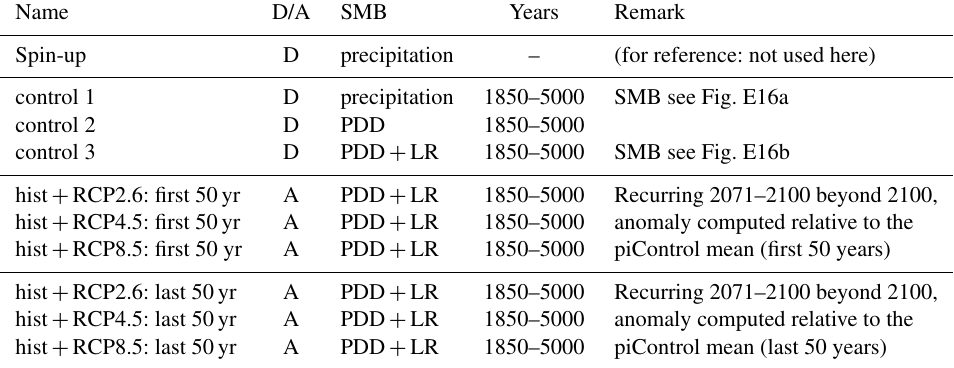
Table 3. Members of the ice sheet model ensemble. The second column “D/A” indicates if forcing has been applied directly “D” or as an anomaly “A”. The third column, “SMB”, represents the surface mass balance, where “PDD” is the positive-degree-day approach, and “LR” indicates the use of an air temperature correction due to a local ice surface height difference utilizing a constant lapse rate. If the entry is “precipitation”, the precipitation of the forcing data set equals the surface mass balance. The “control 1” to “control 3” simulations are driven by the reference data sets (Table 2). Other ice sheet simulations are forced by anomalies on top of the reference data sets. These anomalies are computed relative to the first and last 50 years of the available piControl simulations. We utilize the following CMIP5 scenarios: “piCtrl” – “piControl”; “hist” – “historical”; “RCP2.6”; “RCP4.5”; and “RCP8.5” (Table 1). The CMIP5 scenario “hist” represents the historical period from 1850 to 2004, and the three projections “RCP2.6”, “RCP4.5”, and “RCP8.5” cover the period from 2005 to 2100. Beyond the year 2100, the forcing of the last 30 years (2071–2100) is recurrently applied until the model year 5000. The data set comprises 26 anomaly forcing scenarios. Each scenario starts from the PISM1Eq (Fig. E10) and PISM2Eq (Fig. E11) initial conditions and is driven by two precipitation conditions (see Sect. 2.3 and 2.4 for details). Hence, the ensemble of anomaly ice sheet simulations has 208 members in addition to “control”